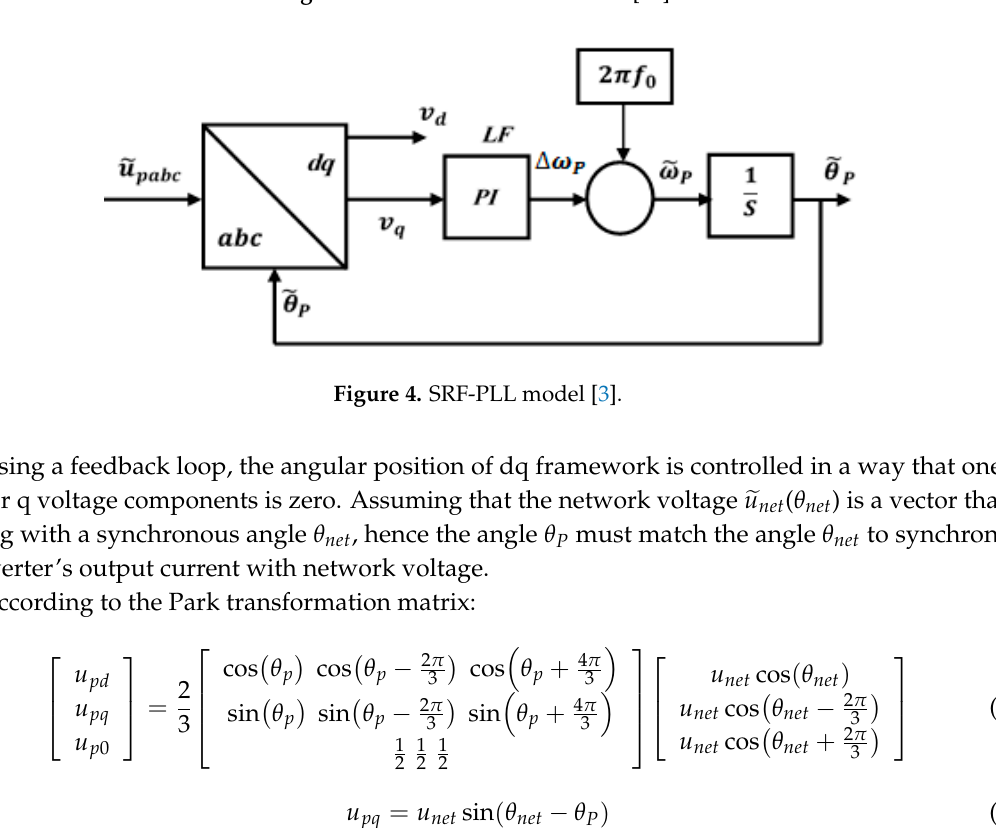
Energies 2018 , 11 , 226